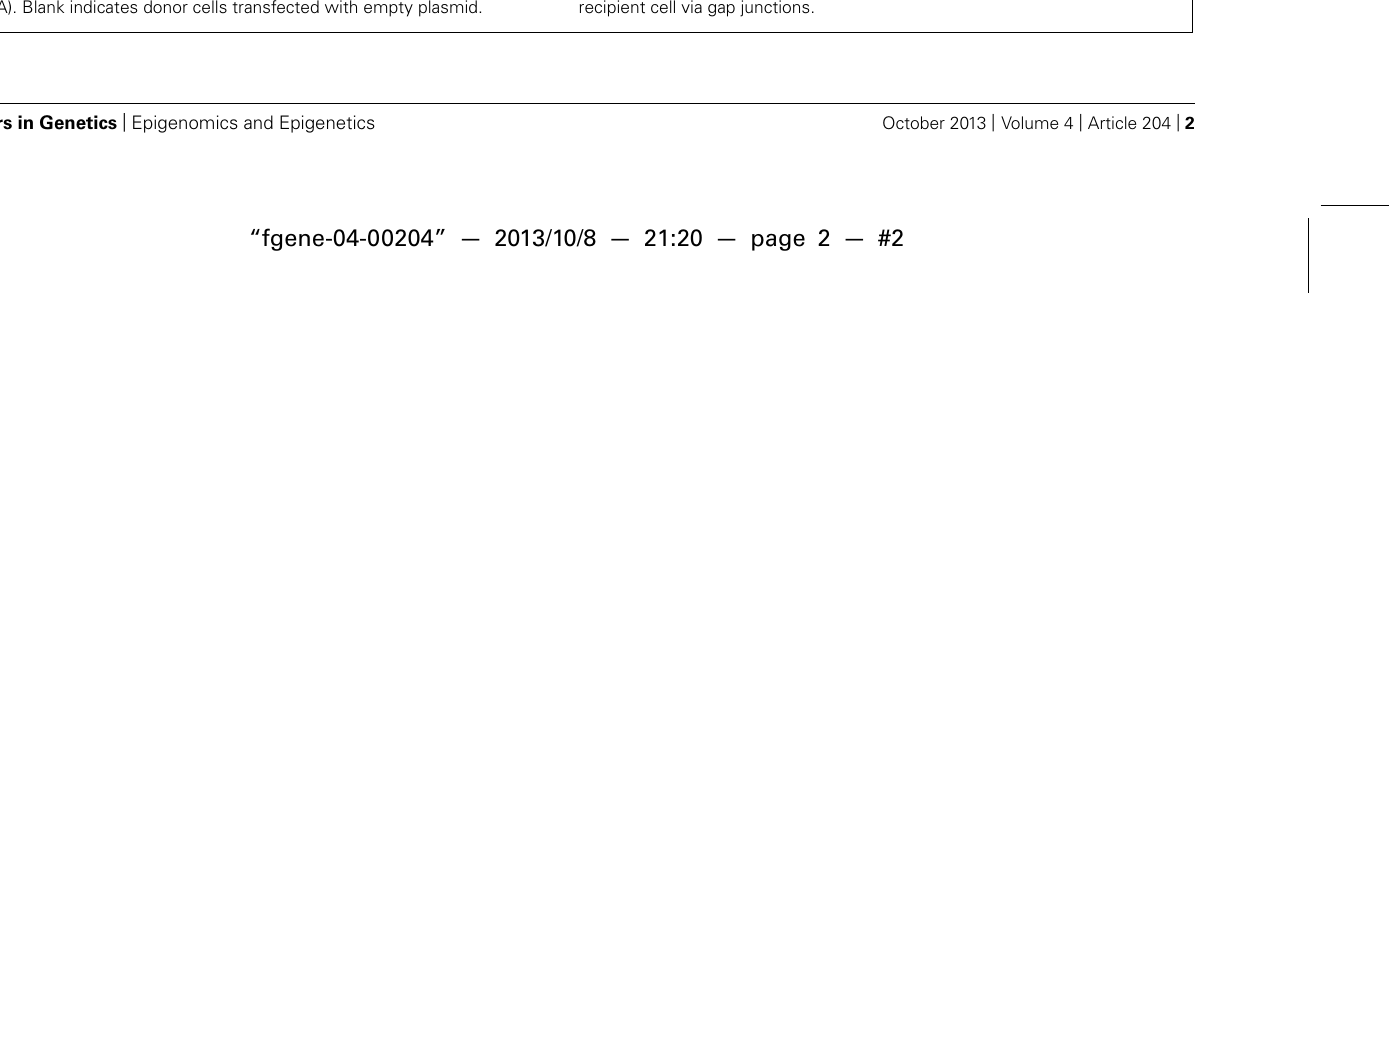
* P < 0.05 vs. blank; ** P < 0.05 vs. miR. (B) Schematic representation of the “mircrine” mechanism: the translocation of miRs from a donor cell to a recipient cell via gap